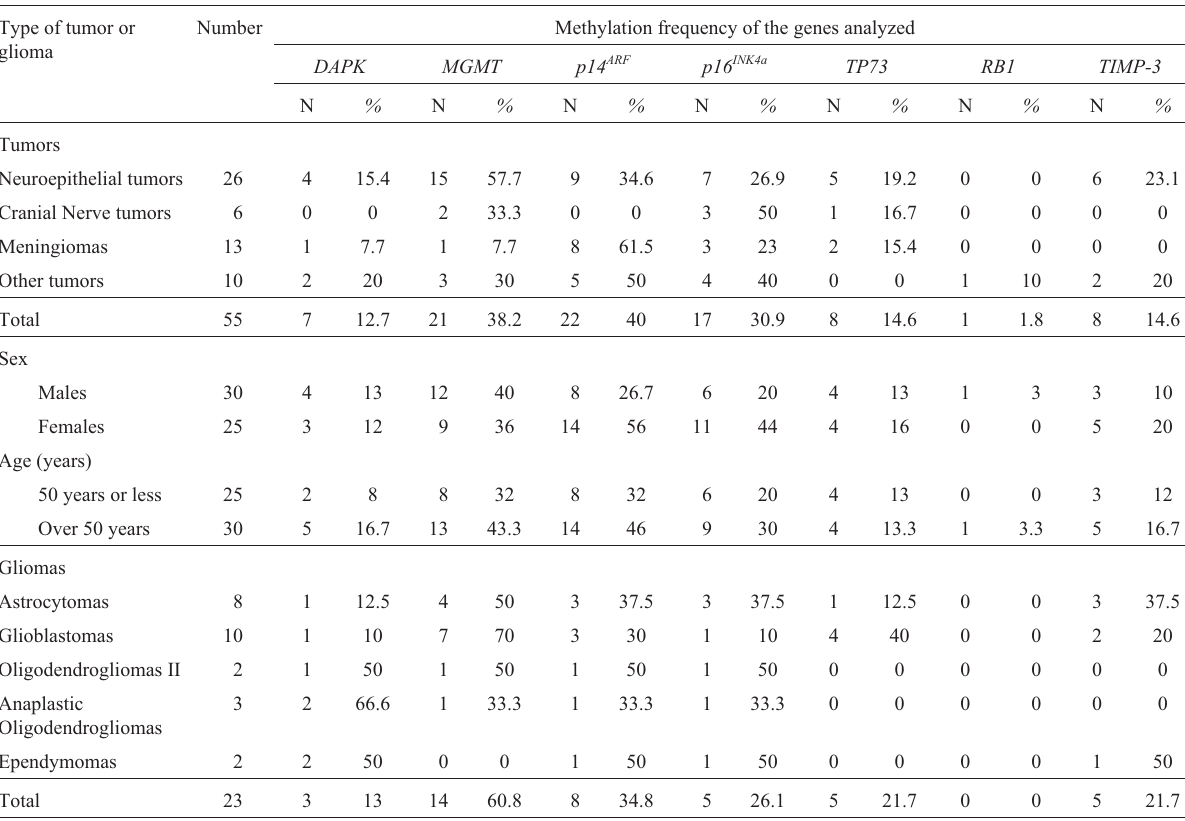
Table 1 - Methylation of brain tumors, relationships between their histological characteristics and the degree of methylation presented by the different genes studied. Type of tumor or